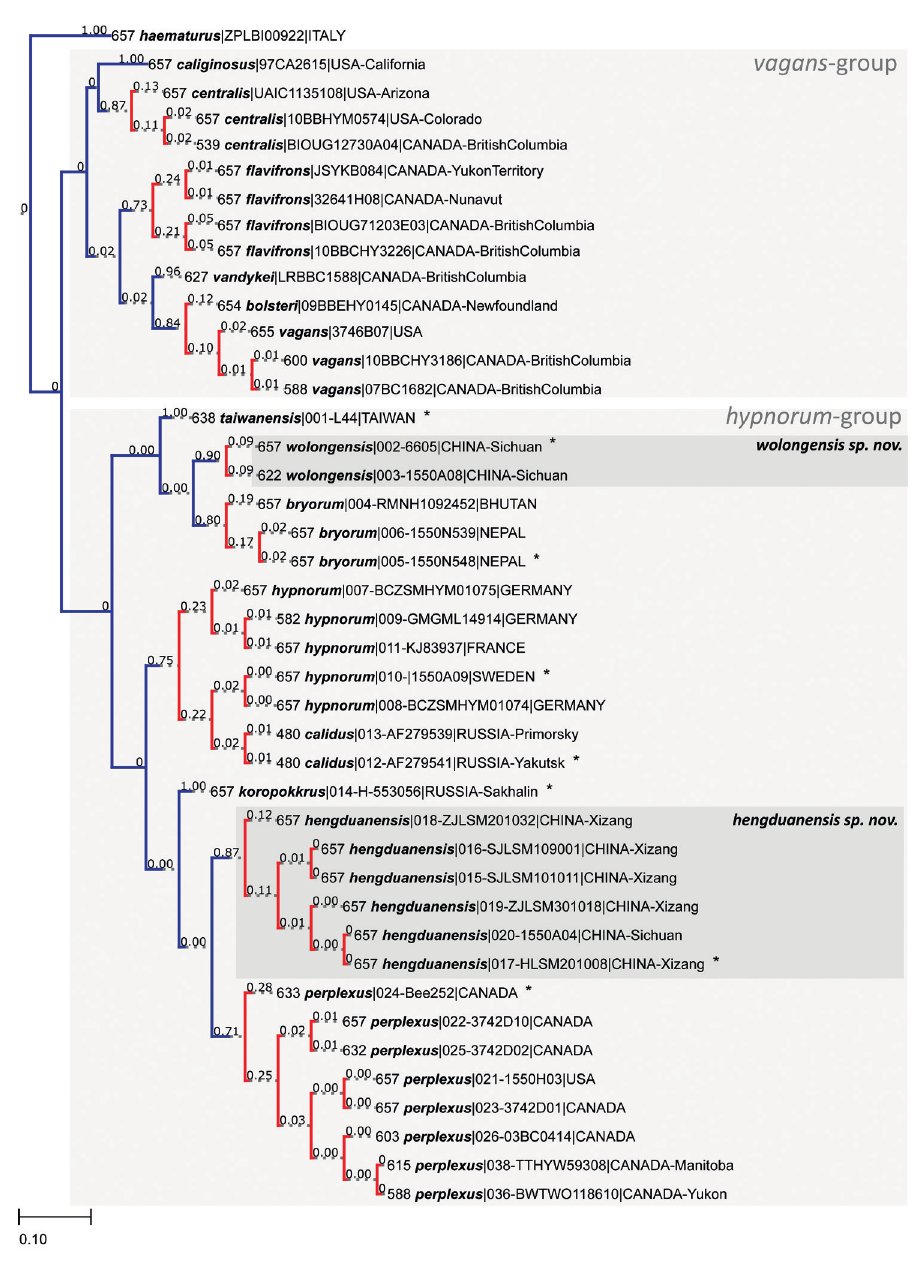
Fig. 1. MRBAYES estimate of phylogeny as a metric tree (outgroup B. alpinus (Linnaeus, 1758) not shown) from COI barcodes from GenBank and BOLD databases for the vagans -group and hypnorum - group, with additions from the authors for the hypnorum- group of bumblebees, filtered to remove duplicate and short sequences. Each sequence is labelled with: sequence length; a taxon name from the database; a code consisting of a sequence identifier from the project database and a specimen identifier from the online database; its country and (for larger countries) state or province). The scale bar is calibrated in substitutions per nucleotide site. Results of Bayesian Poisson-tree-process (PTP) models applied for assessing support for species’ gene coalescents by maximum likelihood are shown as PTP scores above the branches: scores approaching 1 and where branches change from blue to red indicates are where the most likely species’ gene coalescents are detected. Asterisks mark sequences used as informal proxies for the type specimens of each of the taxon names in Table